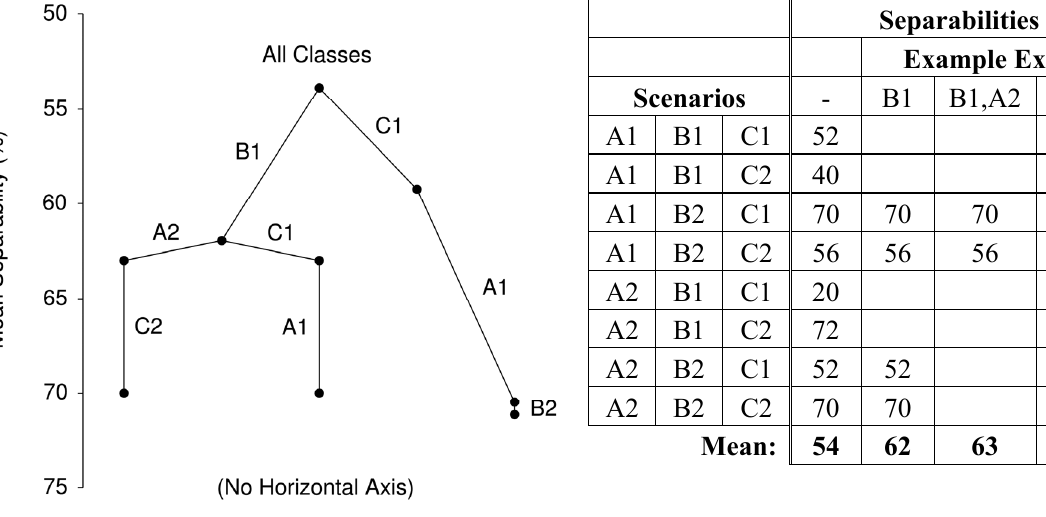
Figure 6. Example construction of an hierarchical analysis diagram. Eight scenarios are produced from a three-factor analysis as all combinations of A1,A2; B1,B2; and C1,C2. The mean separability over all scenarios is 54%, represented by the vertical position of the “All Classes” node. The horizontal position of nodes has no meaning. The left edge of the diagram represents the exclusion of classes B1, A2 and C2 (successive right hand columns of the table). Factors at the lower part of the diagram have the least effect on separability. Separabilities (%) Example Exclusions